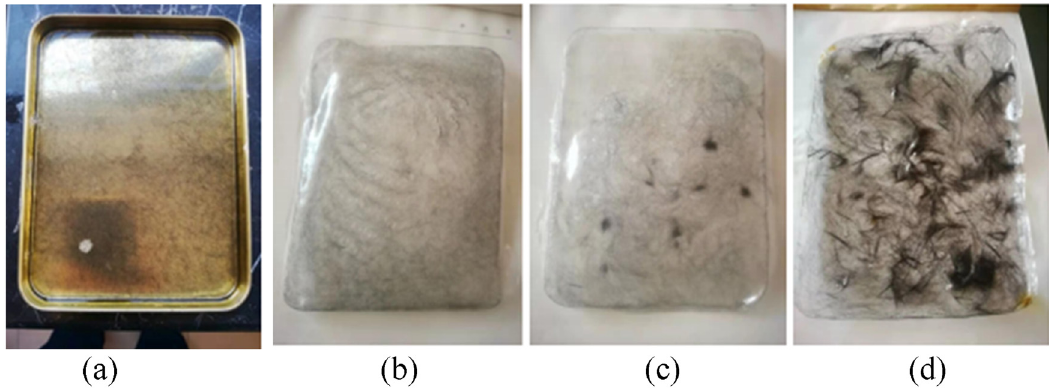
Figure 10: Cast fi lm with CF in PVA solution: ( a ) casting mold, ( b ) fi lm with 3 mm CF fi lament, ( c ) fi lm with 6 mm CF fi lament, and ( d ) fi lm with 10 mm CF fi lament.